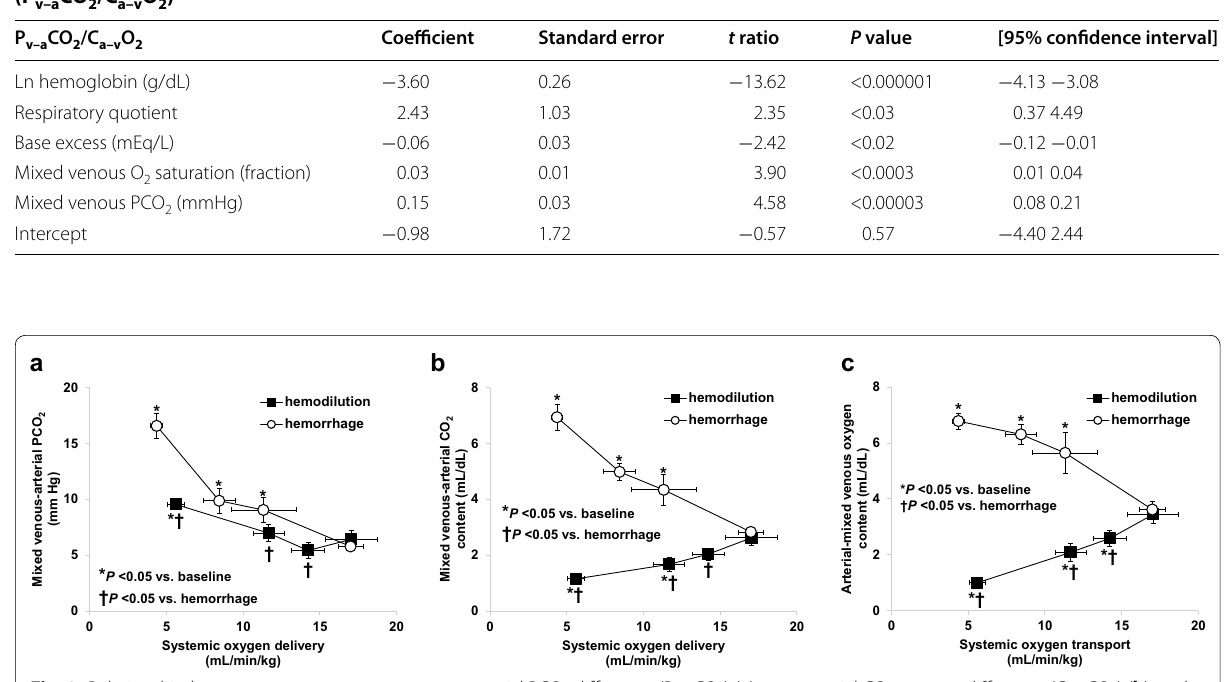
to arteriovenous oxygen content difference 2